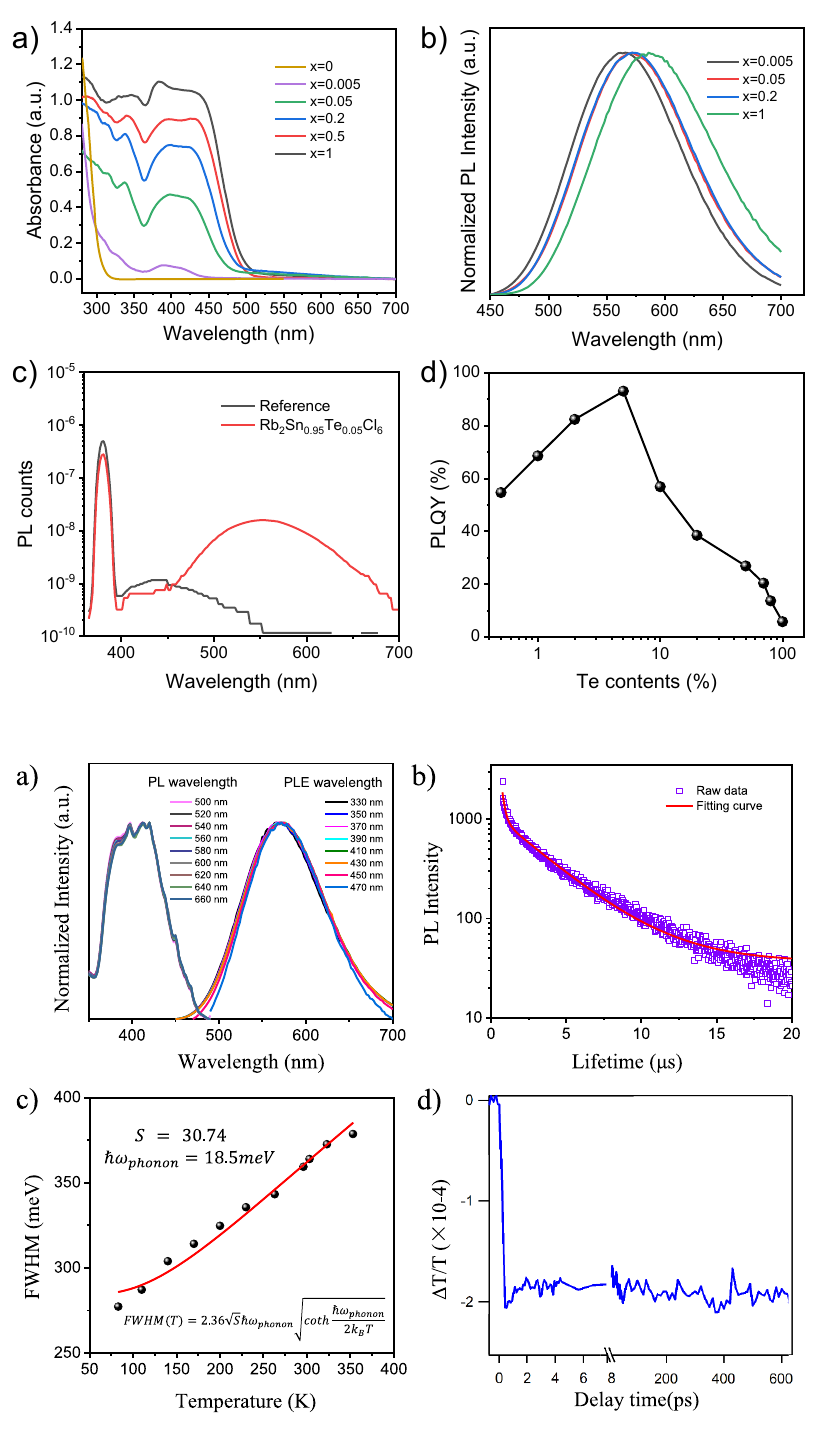
The transient absorption measurements on Rb 3 Ag Na InCl (51.0) Te Cl provide the formation kinetics of STEs (Figure 3d). 2 0.16 0.84 6 0.05 6 Upon excitation at 400 nm, the sample showed a broad featureless photo-induced absorption (PIA) signal from 430 to 480 nm. The PIA signal rises within ∼ 300 fs, sug- gesting anultrafast exciton self-trapping process. According